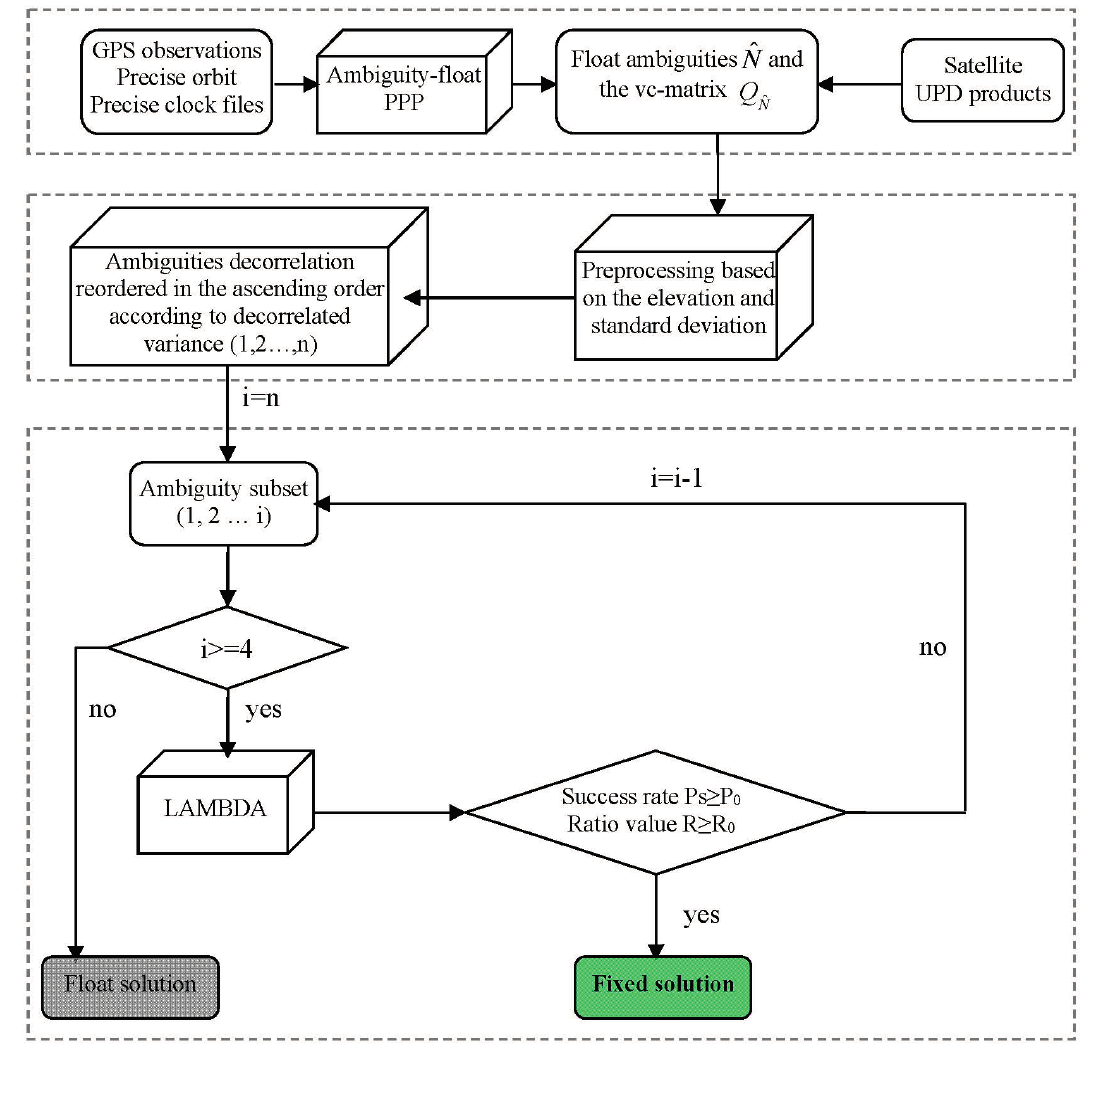
Figure 1. A flowchart of partial ambiguity resolution with predefined success rate and ratio